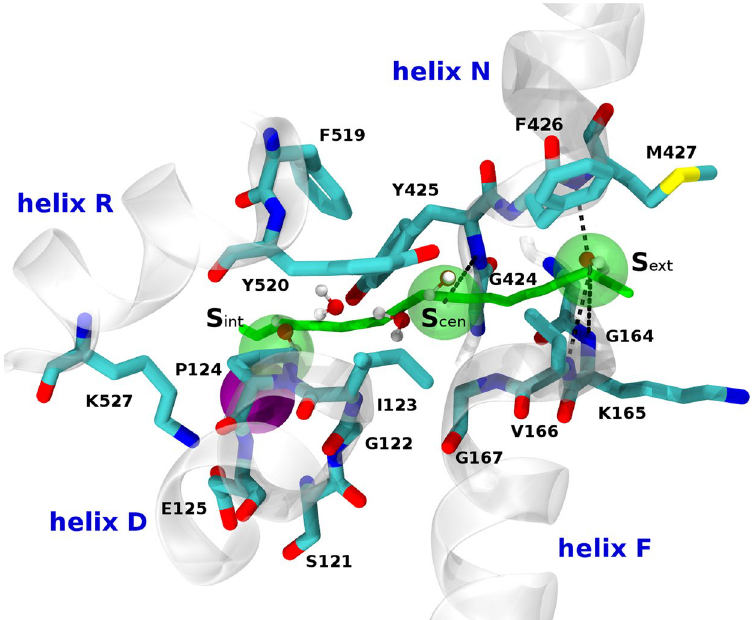
Figure 3. Chloride path into the ClC-Kb pore. The three experimentally known positions of the chloride ion (S ext , S cen and S int ) in CmCLC and EcClC are shown (green spheres). The predicted path of the chloride ion obtained from the MD simulation is shown as a green stick. Important helices are shown in a cartoon representation. Residues forming the channel pore are represented as sticks and the black dotted lines represent putative electrostatic interactions between the three possible chloride ion positions and the NH group of the protein backbone. The chloride ion interacting with the pore during the MD simulation is represented as a purple sphere. The water molecules present in the simulation are in a ball and stick